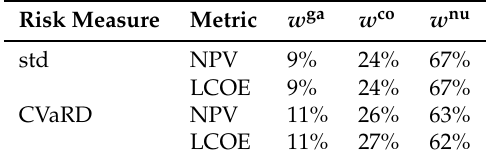
Table 6. The composition of minimum risk portfolios in the 30-year portfolio selection problem. The three-asset case.